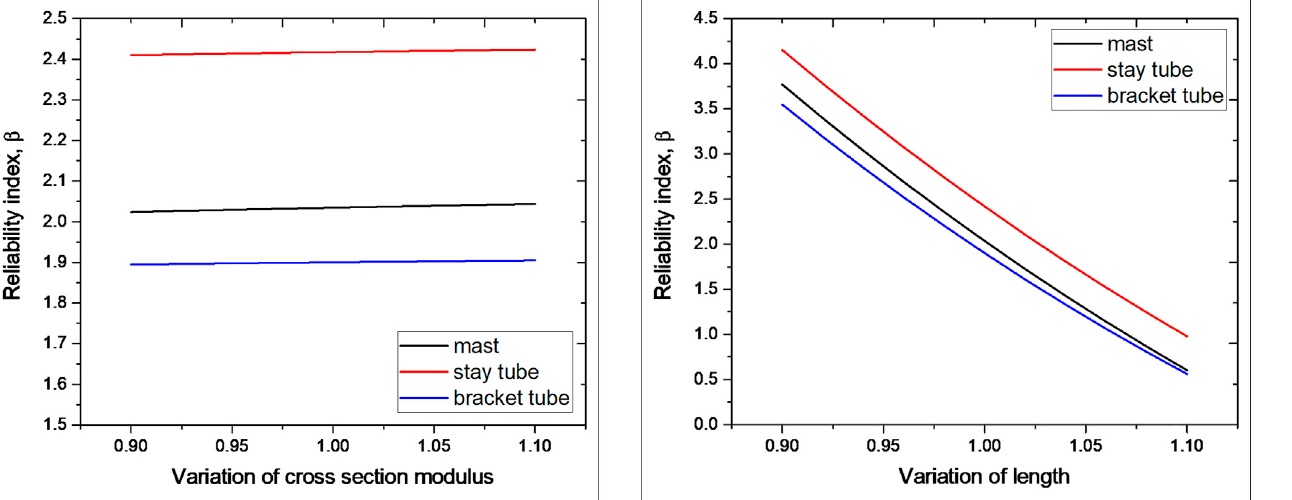
FIGURE 5 | Effect of cross section modulus variation on reliability index. FIGURE 6 | Effect of length on reliability index.